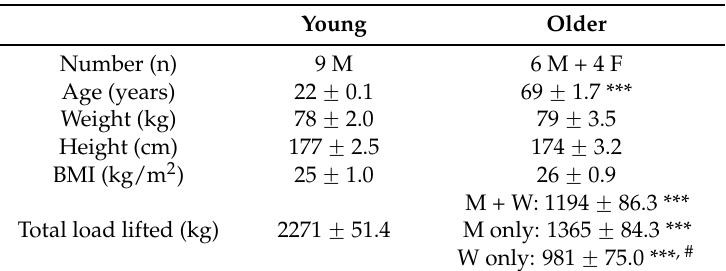
Table 1. Subjects